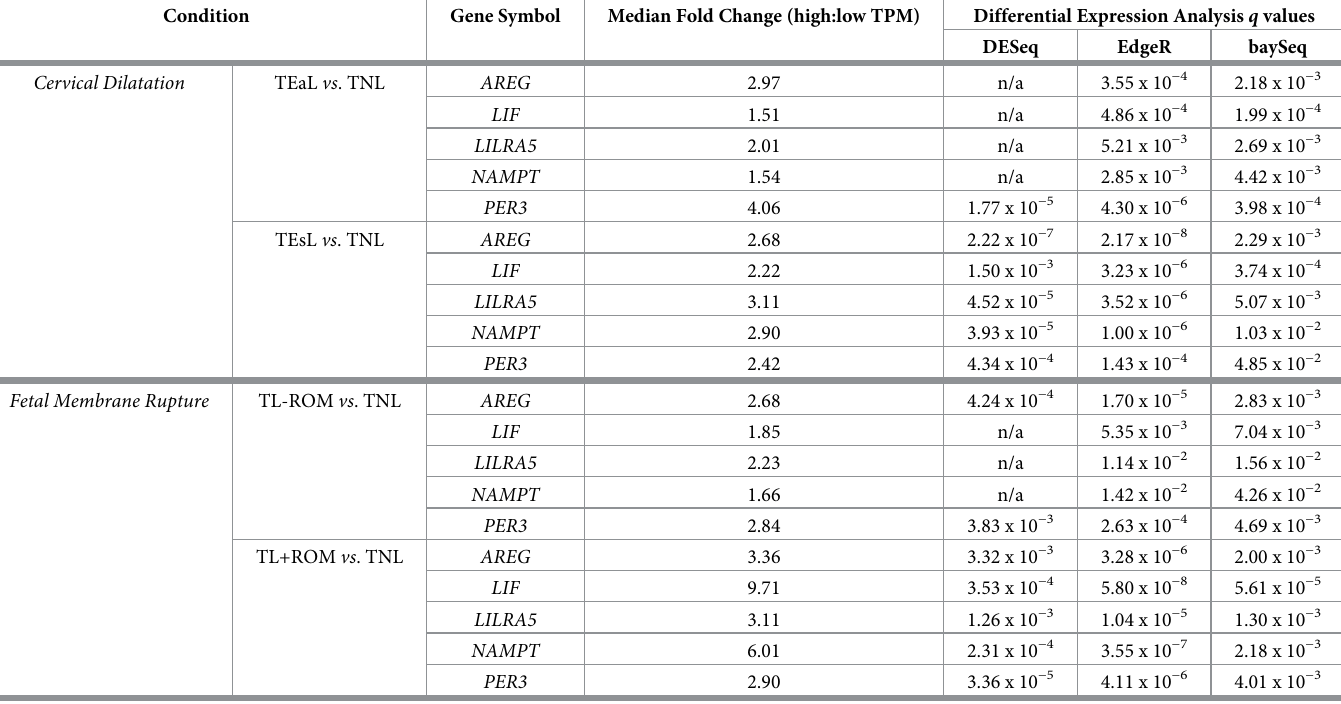
Table 7. RNA-seq summary for differentially expressed genes common to four labour classifications in human myometrium. Condition